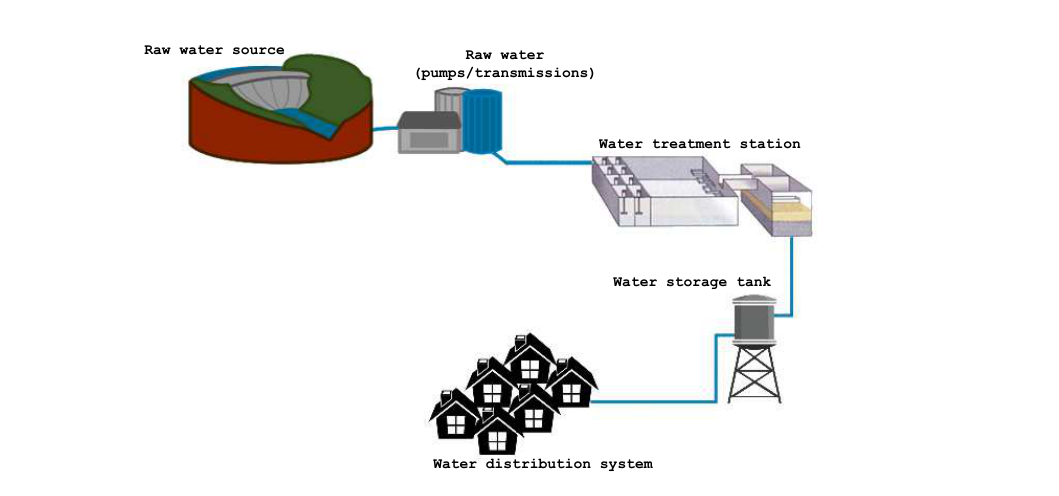
Figure 5. Water life cycle of a water supply